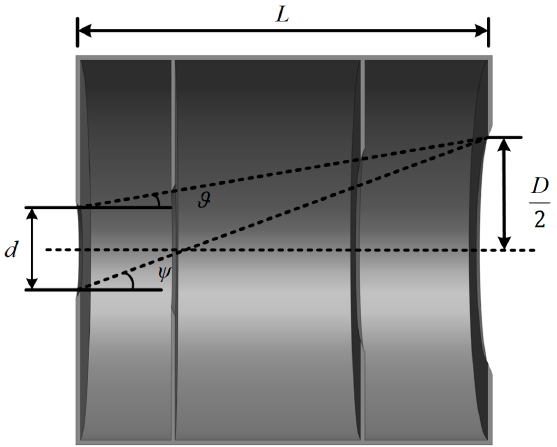
Figure 4. Basic baffle design for length and outer aperture diameter.